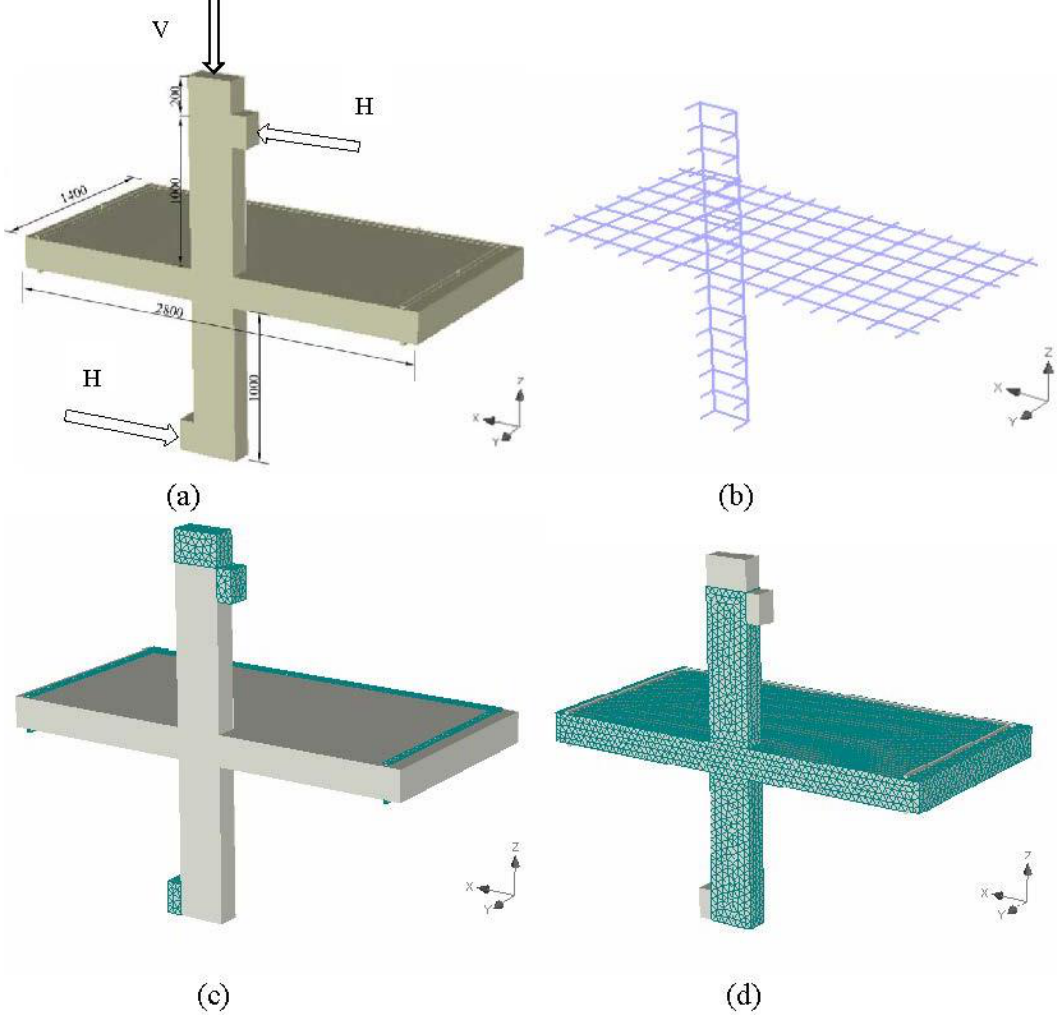
Figure 5. ATENA-3D model. ( a ) Model geometry; ( b ) Reinforcement configuration; ( c ) Loading and supporting plates (meshed); ( d ) Slab and column